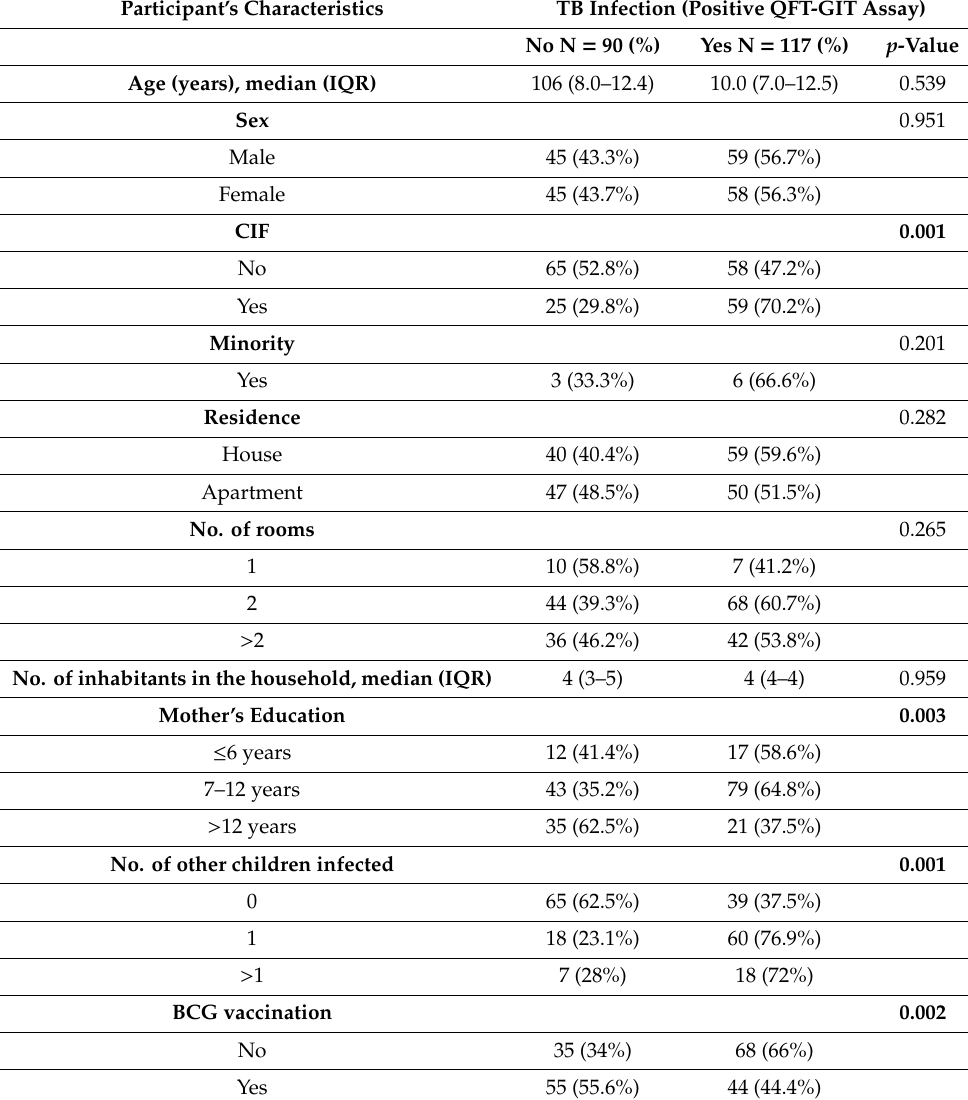
Table 2. Associations between participants’ characteristics and tuberculosis (TB)